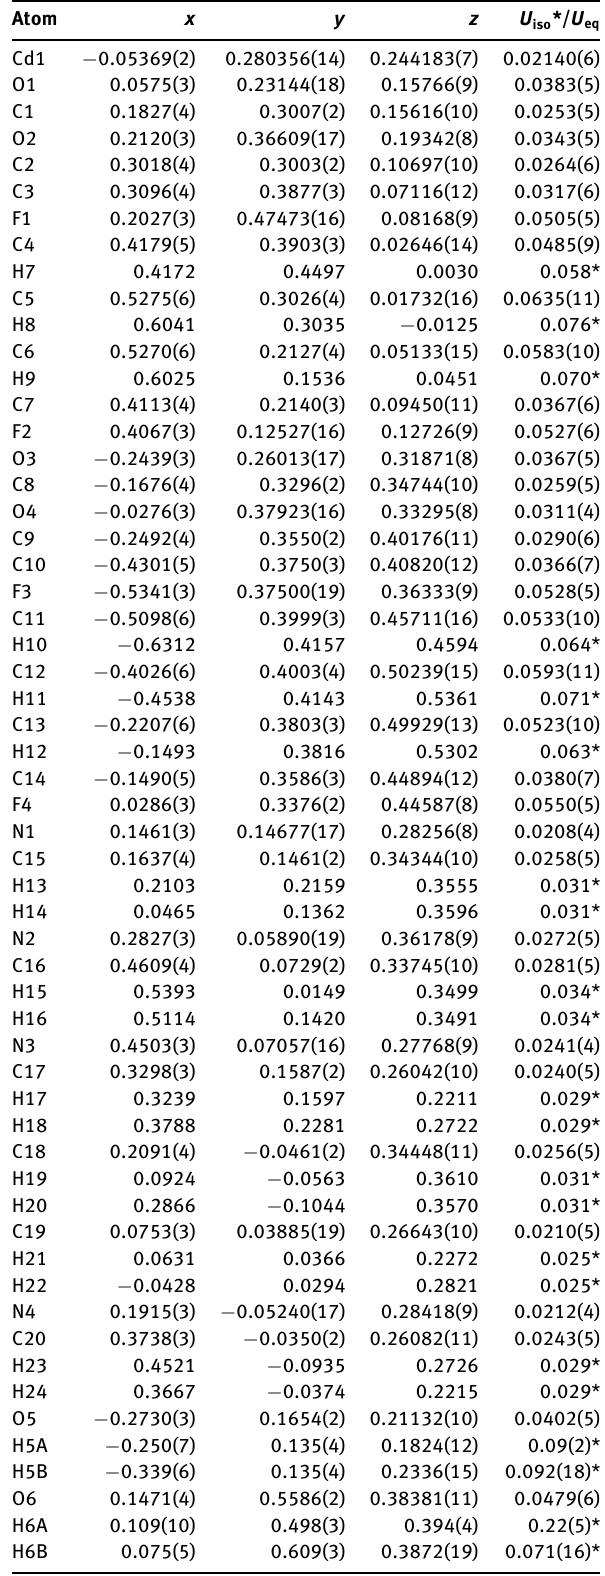
Table 2: Fractional atomic coordinates and isotropic or equivalent isotropic displacement parameters (Å 2